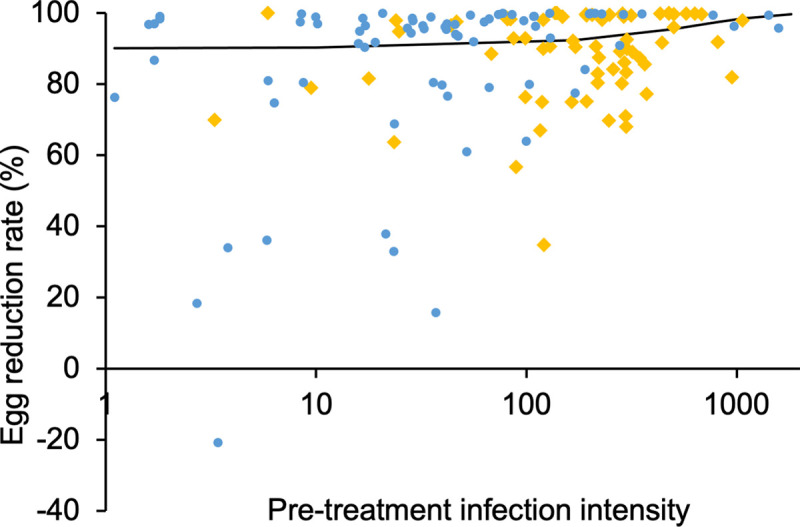
Scatter graph of the reported egg reduction rate in percentage vs pre-treatment infection intensity (eggs/10ml urine for S. haematobium in blue circle and eggs/g of feces for S. mansoni in orange diamond).The fitted line is from a random effects meta-regression model which confirmed statistically significant association between pre-treatment infection intensity and egg reduction rate [F = 11.257 (1, 118), p = 0.001]. For this model both schistosome species and type of pre-treatment infection intensity mean (arithmetic and geometric mean) were considered. A total of 134 observations from 70 articles were used for this analysis.